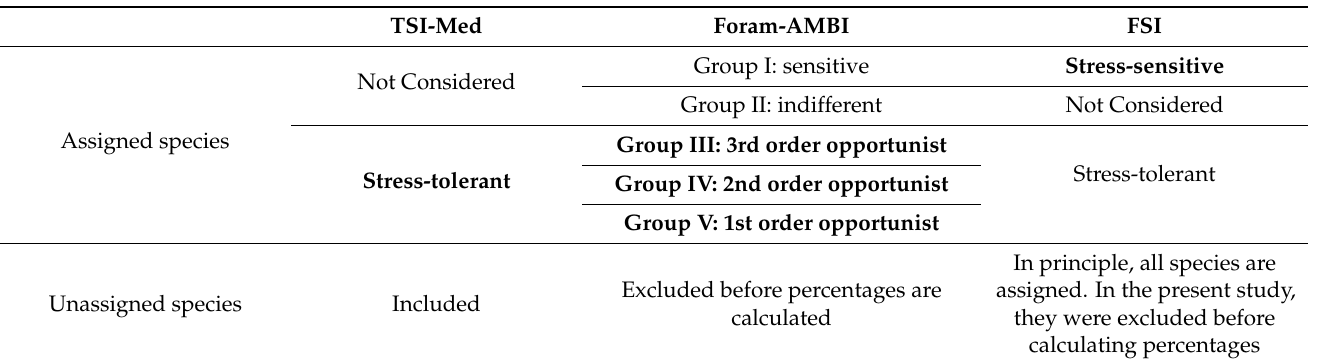
Table 2. Groups of indicator species considered by TSI-Med, Foram-AMBI, and FSI indices, and equivalences considered in this study. Species groups that contribute most to the value of the biotic index are in